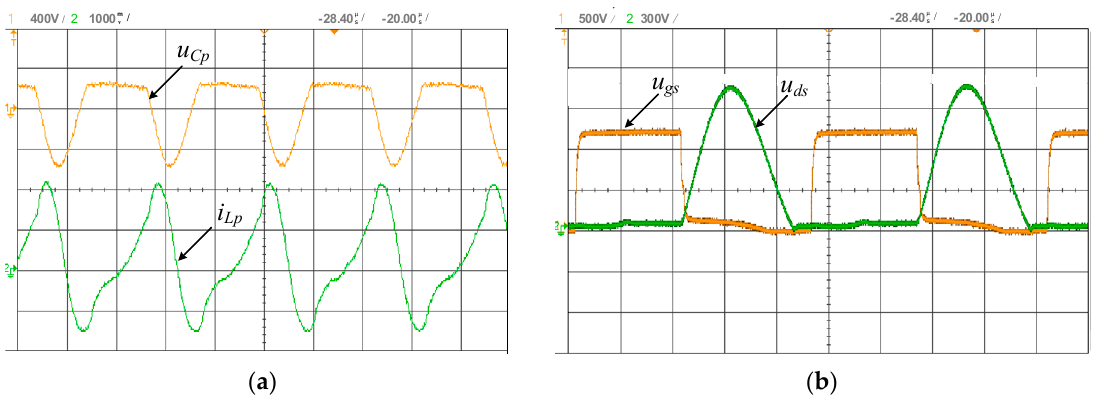
Figure 12. Experiment results. ( a ) Current and voltage waveforms of transmitting circuit. ( b ) Drive voltage and voltage waveform between drain and source.